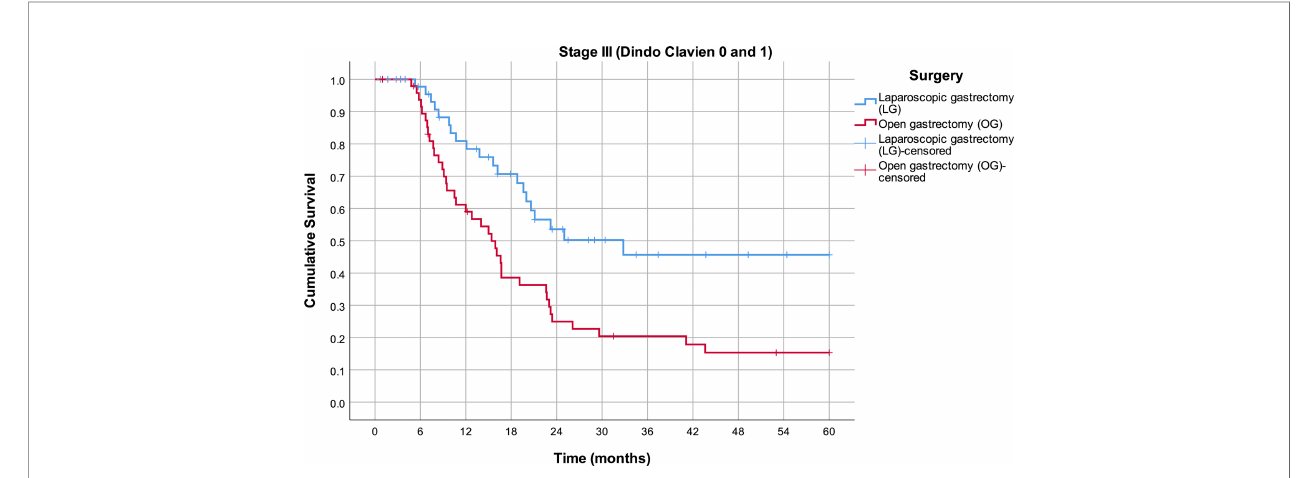
FIGURE 4 | Estimated mean survival for the Clavien – Dindo group 0 and 1 patients in stage III disease, in respect to the operative